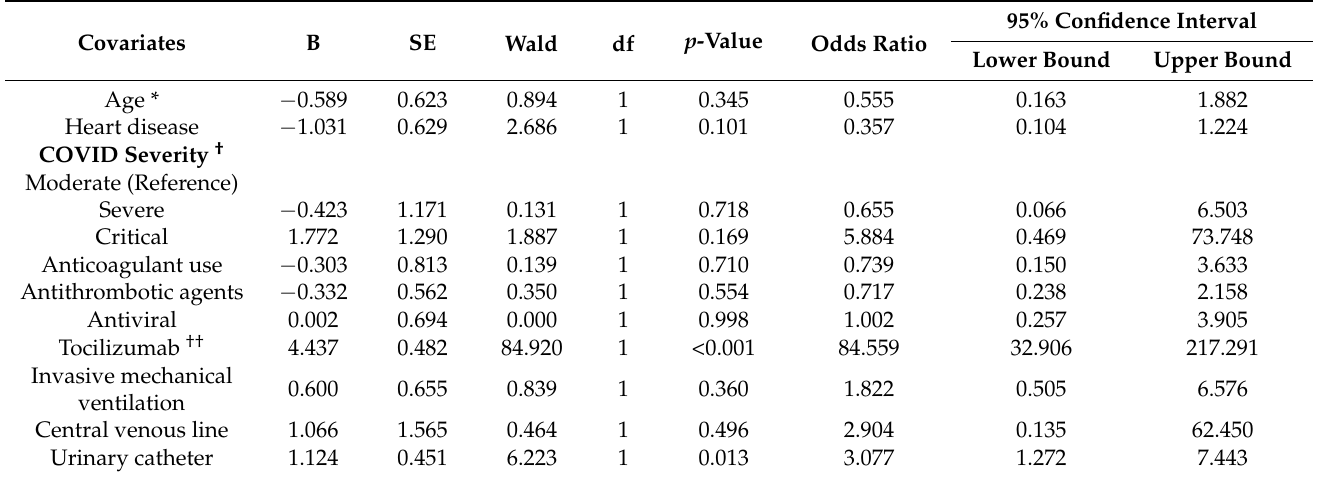
Table 2. Factors associated with the development of healthcare-associated infections (HAIs) in COVID-19 patients.